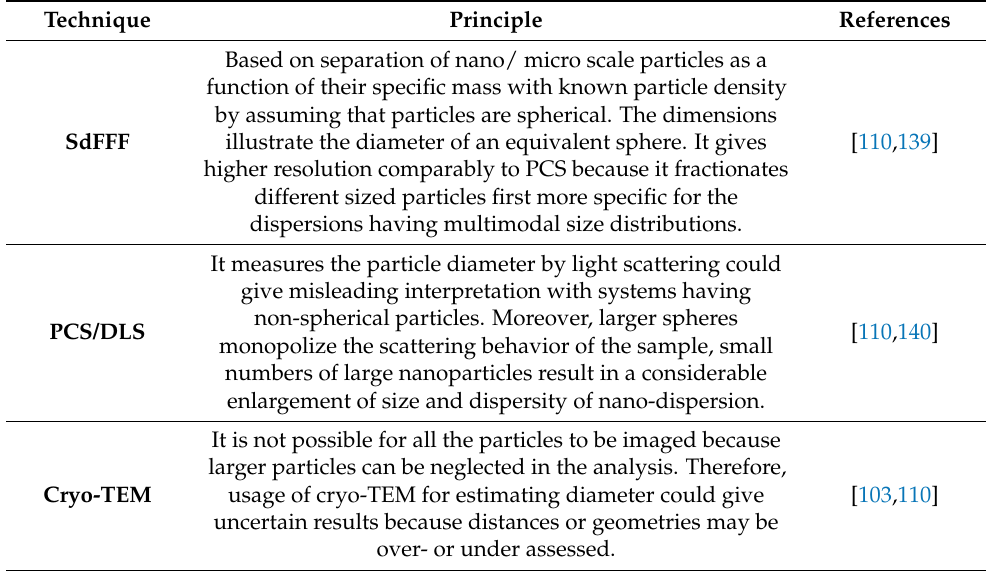
Table 4. Comparison between SdFFF, DLS, and